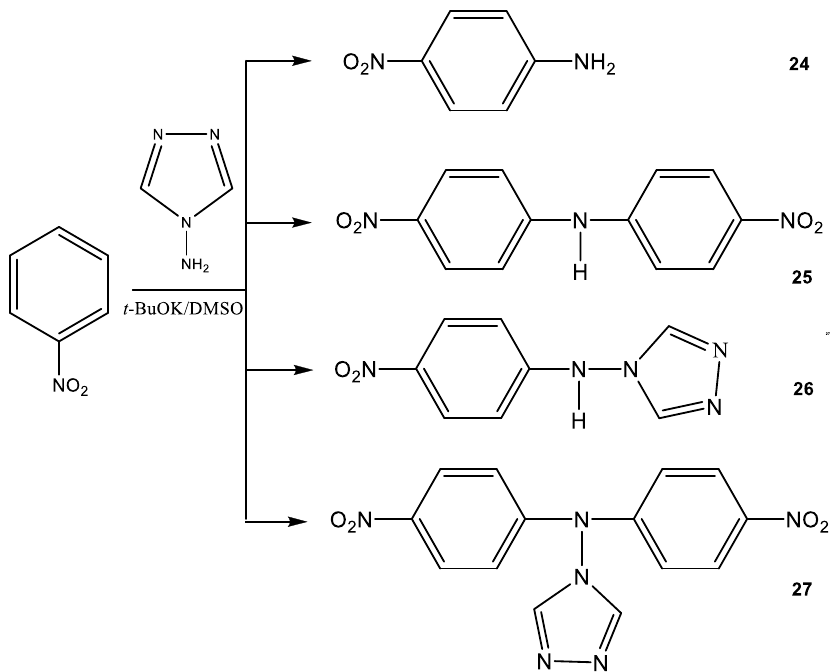
Scheme 14. Products of the interaction of nitrobenzene ( 23 ) with 4-amino-1,2,4-triazole ( 19 ) in a superbasic medium.